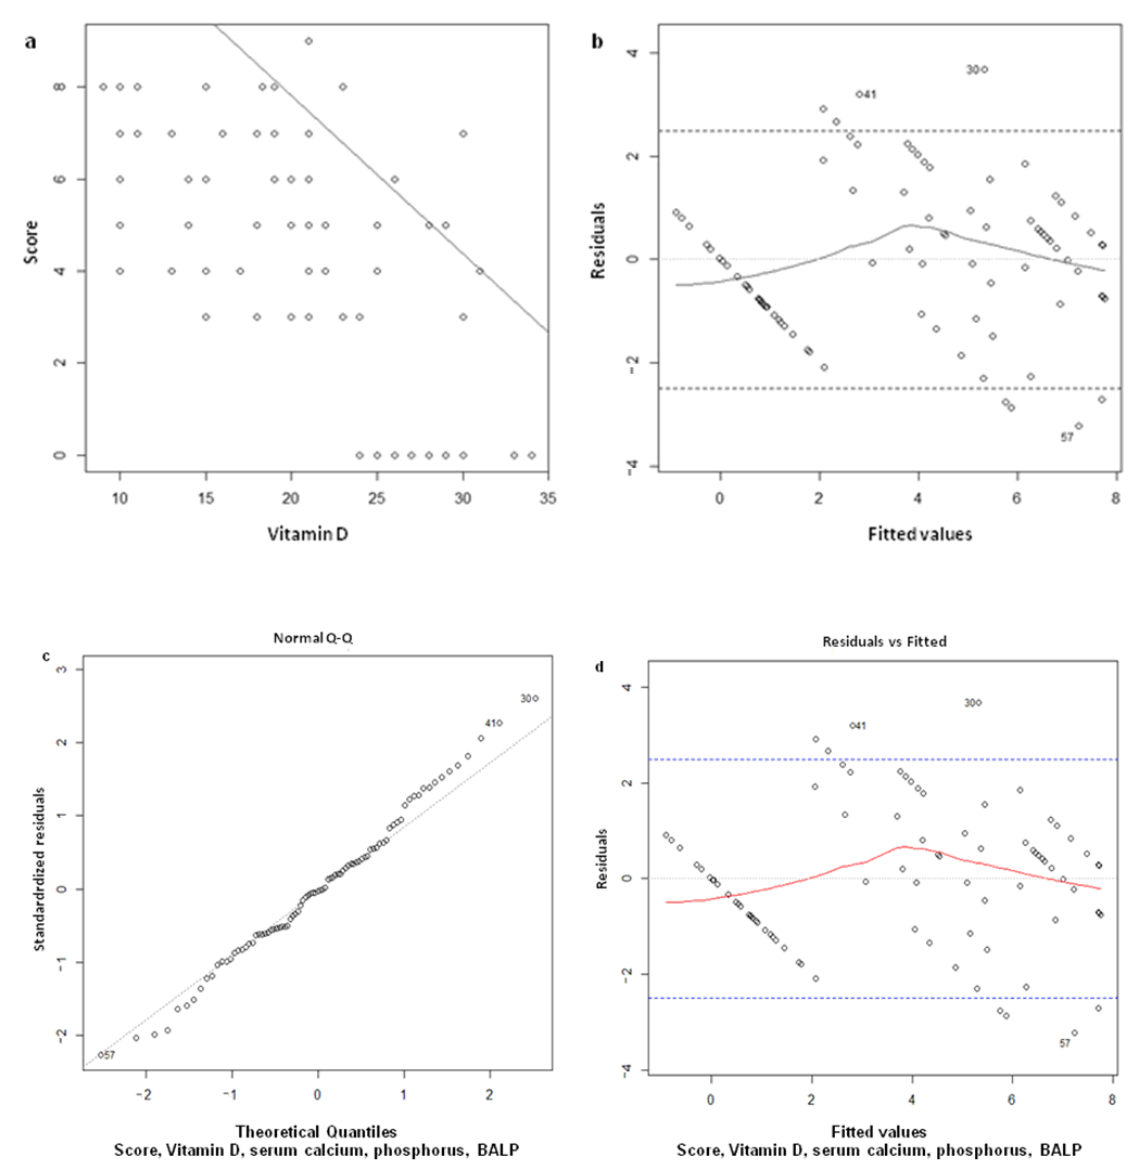
Figure 3. ( a ) Regression line score vs. vitamin D; ( b ) verification of hypotheses of linearity by studying the residuals with respect to the theoretical values of the model. The graph shows a slight asymmetry around 0, which could be considered acceptable in view of the number of samples; ( c ) verification of the residues’ normality, comparing those utilized in the model to a standard normal distribution. The hypothesis is fully respected and verified by the Shapiro-Wilk test ( p -value = 0.83); ( d ) verification of homoskedasticity, comparing the square root of the standard residuals to the model’s values. Although the graph does not show an ideal situation, homoskedasticity was verified by the Breusch-Pagan test ( p -value observed >